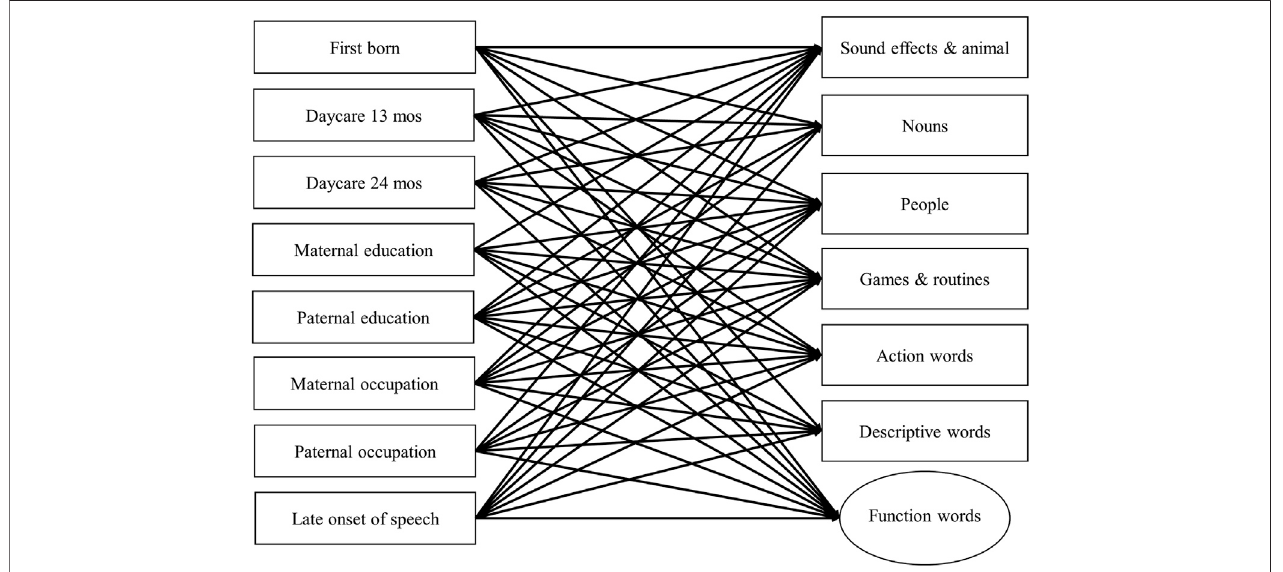
FIGURE 1 | Conceptual model of the hypothesized relations between the study constructs.